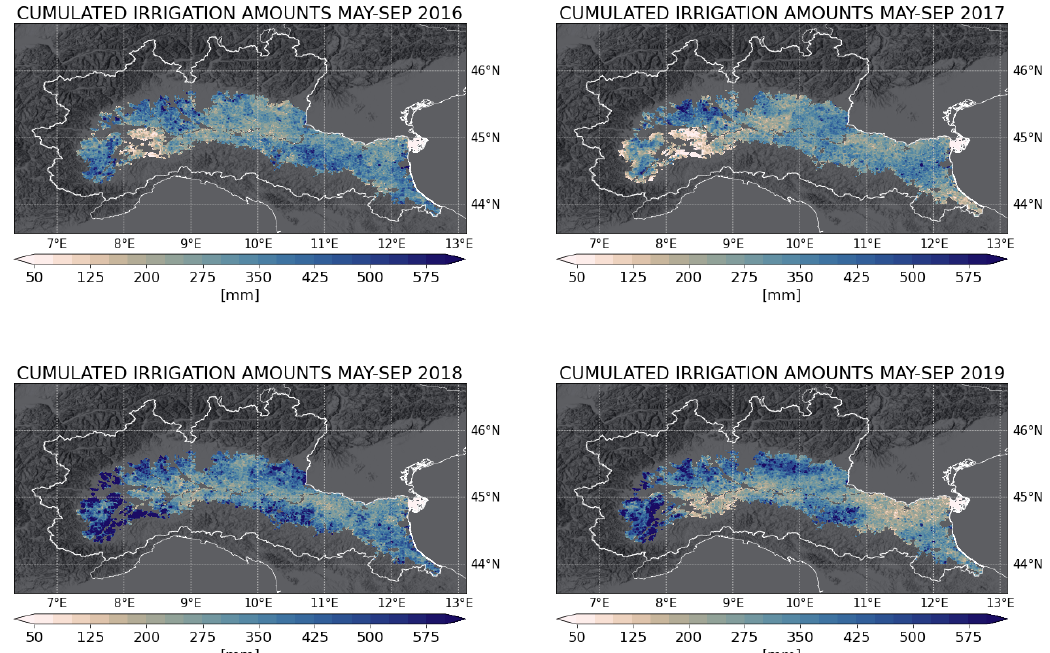
Figure 6. Cumulated irrigation amounts over the Po valley (Italy) during the highest-intensity irrigation season (May–September) of 2016, 2017, 2018, and 2019.